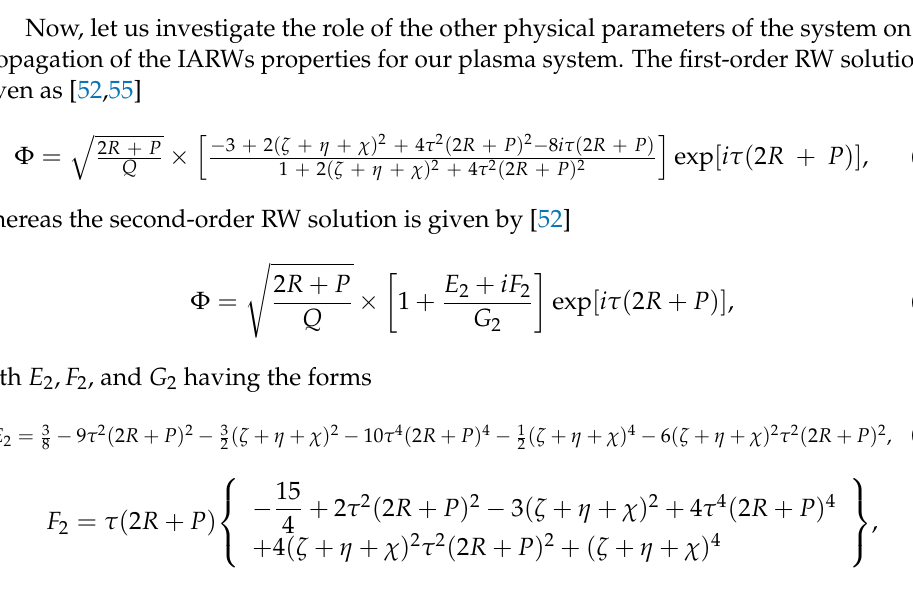
Figure 1. Plot of the product PQ = 0 versus ω and θ for different values of r with q = 2 ( a ), q with r = 0.7 and σ = 0.3 ( b ), and σ with r = 0.7 and q = 2 ( c ). Here, β 1 = 0.6, β 2 = 0.3, and ω ci =